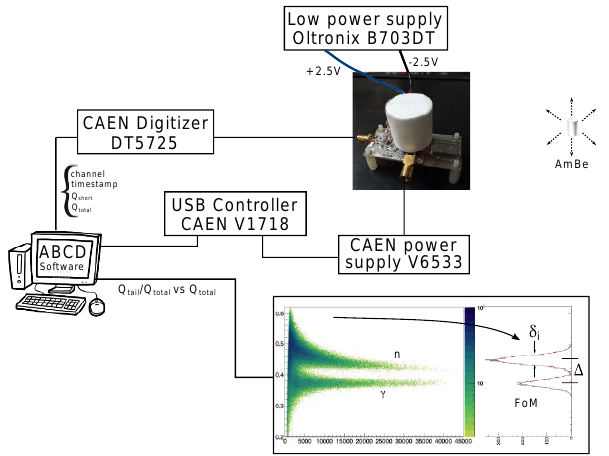
Fig. 3. Experimental set-up. 1” x 1” EJ-276 scintillator coupled to the NUV- SiPM array is shown.